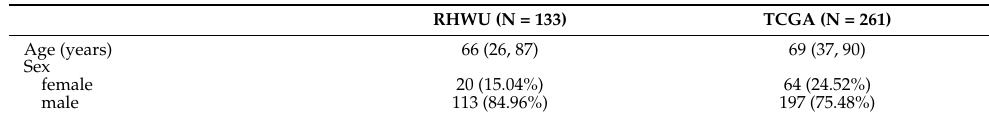
Table 1. The distributions of demographic and clinicopathologic characteristics of MIBC patients in the two